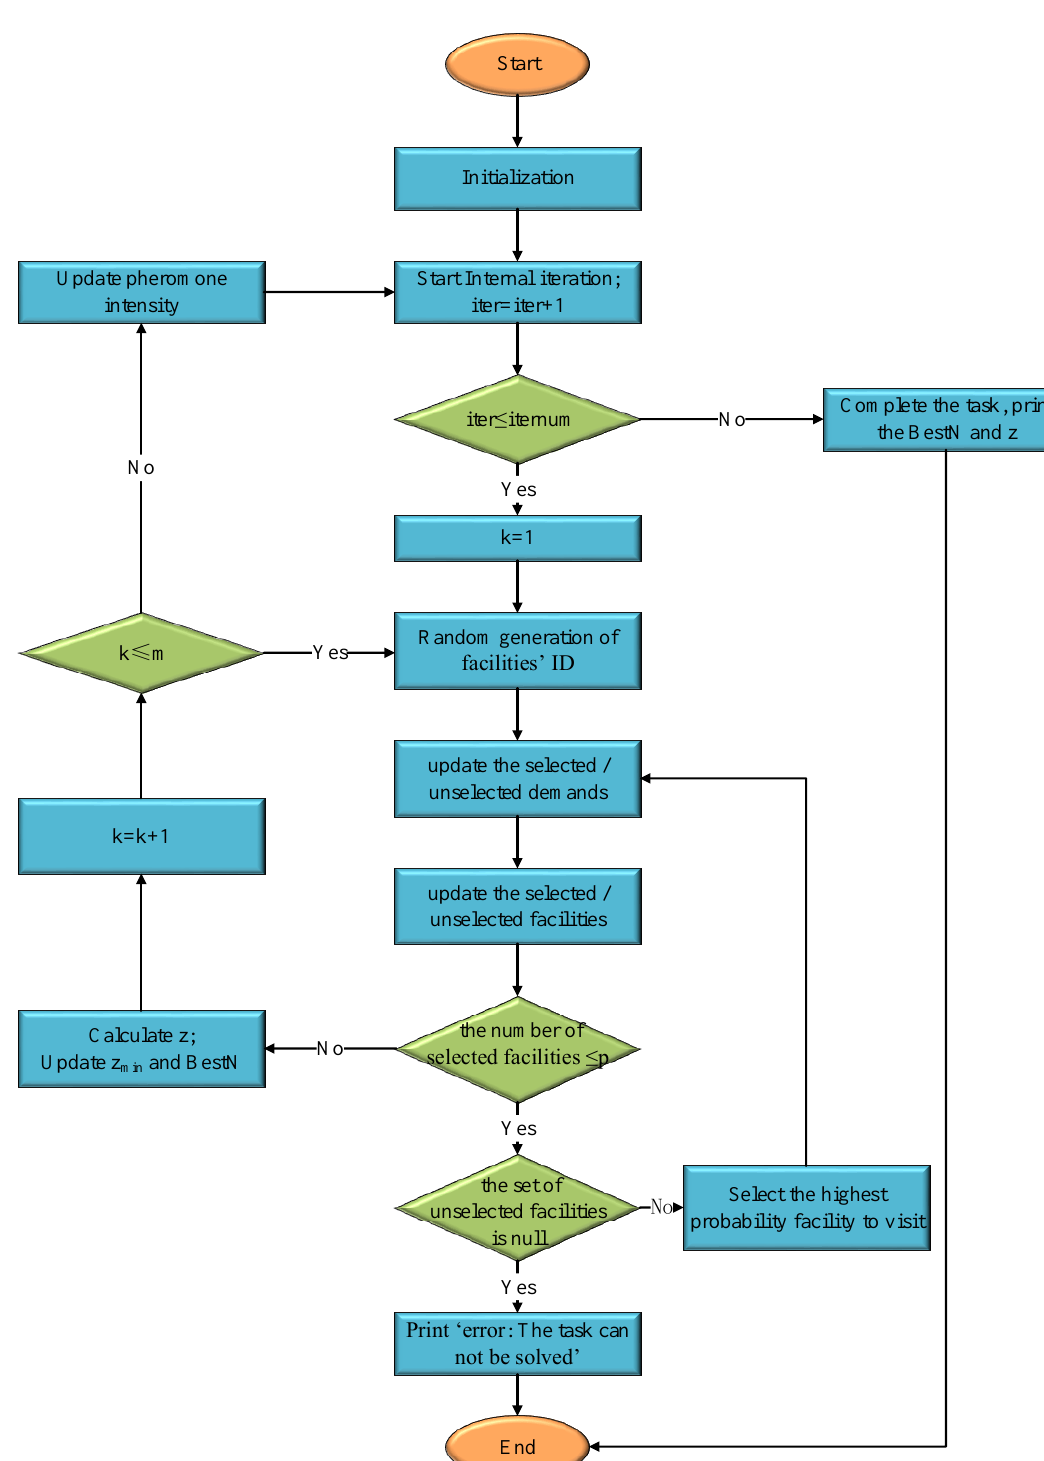
Figure 5. The flowchart of the Ant Colony Optimization algorithm.